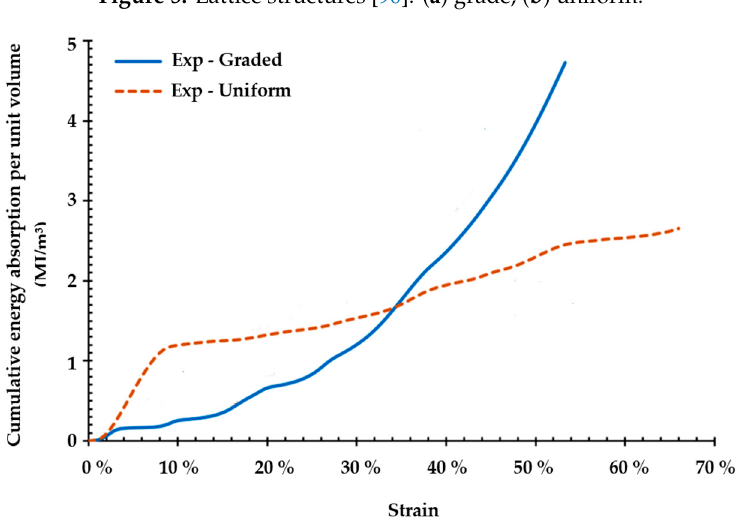
Figure 6. Cumulative energy absorption per unit volume vs. compressive strain curves of uniform and graded structures [90].